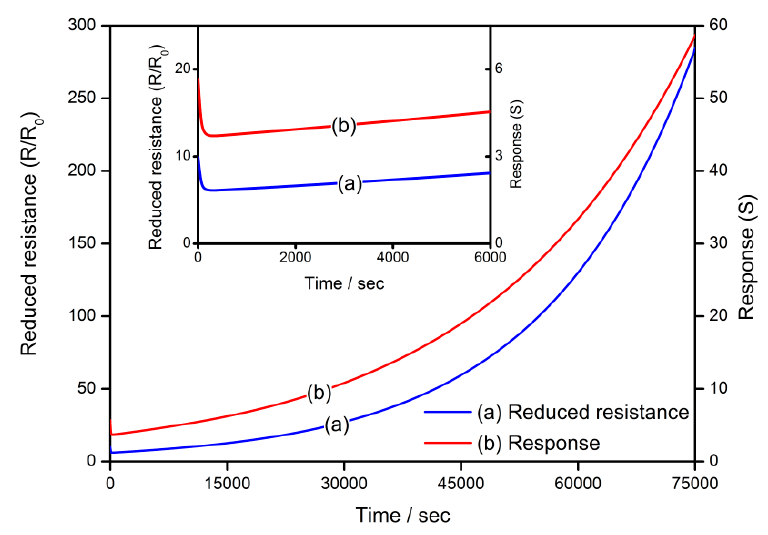
Figure 10. Transient states of gas-sensing characteristics of a semiconductor gas sensor during the cooling process.